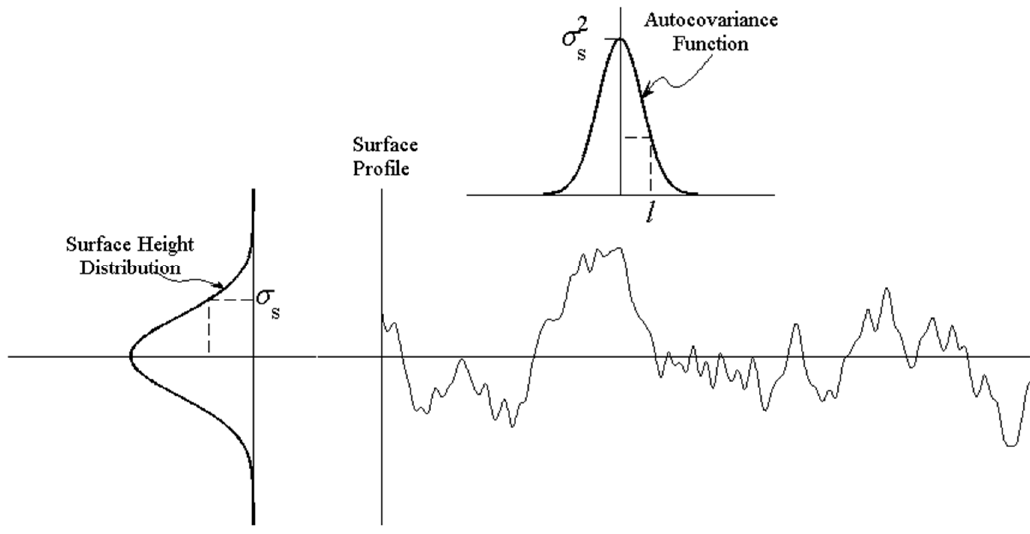
Figure 4. Illustration of statistical parameters used in characterizing surface roughness.